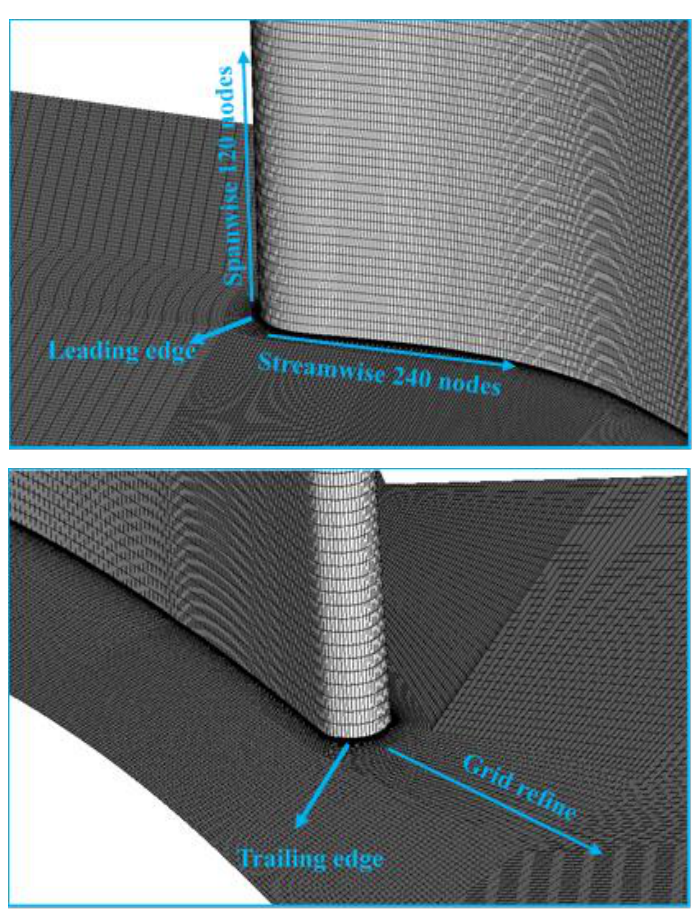
Figure 5. Computational domain.